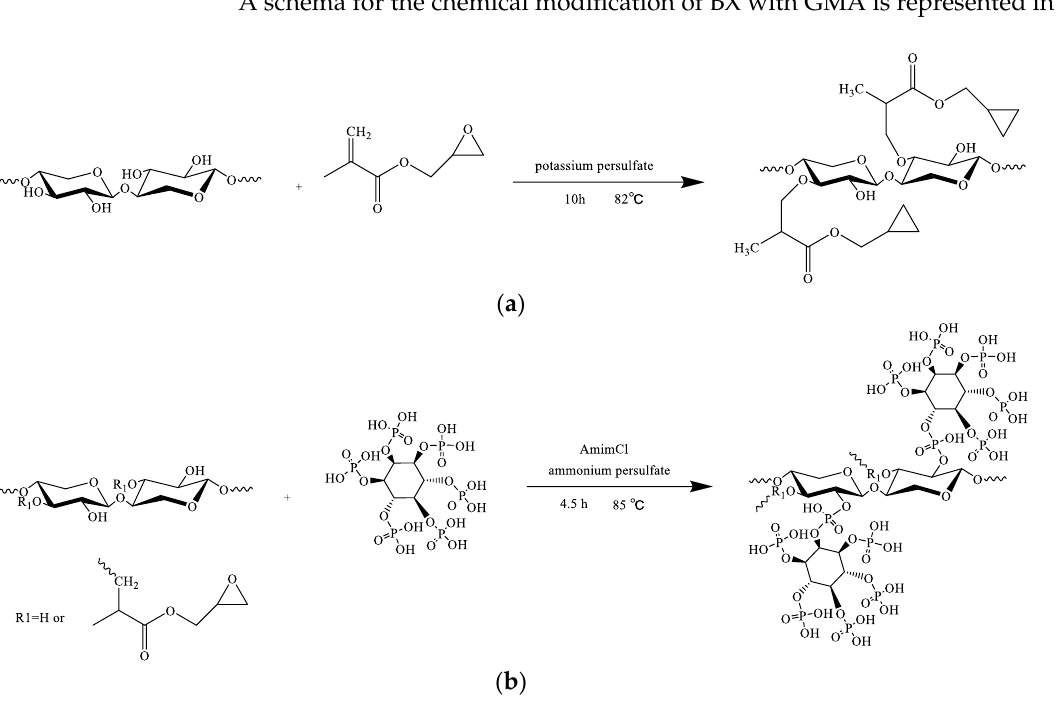
Figure 1. The synthesis routes of ( a ) GMA BX and ( b ) GMA